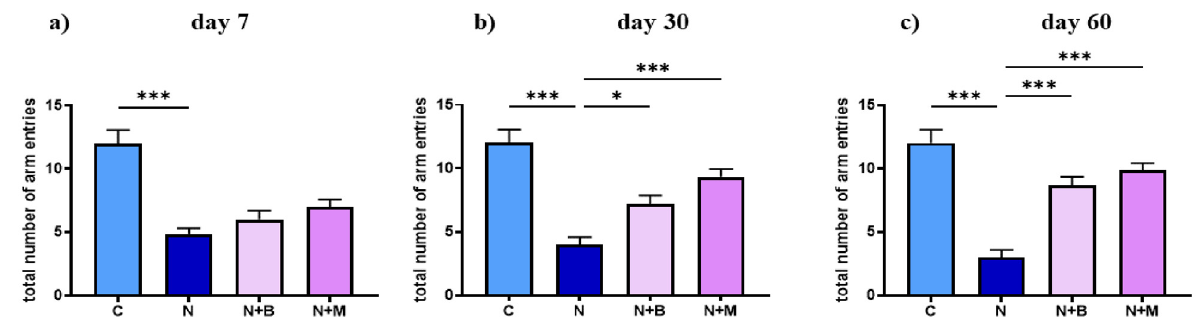
Figure 7. Total number of entries in Y-maze. Animals ( n = 6) were treated for 60 days with noise (N) or left untreated (C). Mesedin (M) and beditin (B) were injected daily i.p. to the rats exposed to chronic noise (N + M and N + B, respectively). One-way ANOVA with Sidak’s multiple comparison test, * p < 0.05, *** p < 0.001. Total number of entries reflecting the mobile episodes on days 7, 30, and 60 of noise exposure and mesedin/beditin are shown in ( a ), ( b ), and ( c ), respectively. Data are shown as mean ± SEM.